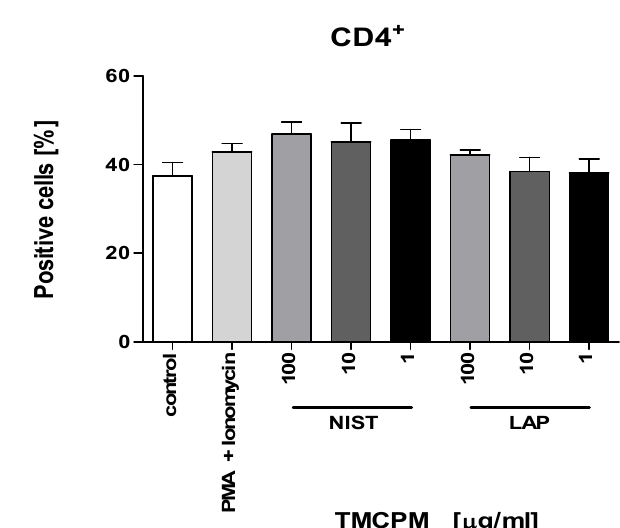
Figure 1. Effect of TMCPM (NIST or LAP) on the level of expression of CD4 on the surface of T cells and frequency of CD4+ T cells. PBMC were stimulated for 5 h with PMA + ionomycin or with NIST or LAP particles, stained with anti-CD4-PerCP-Cy5.5 conjugated mAb and analyzed by flow cytometry. ( A ) Histogram overlay shows fluorescence intensity (PerCP-Cy5.5) of CD4+ cells. Grey histogram—fluorescence intensity of CD4+ cells in a control culture (without stimulation), black histogram—fluorescence intensity of CD4+ cells in the samples stimulated either with PMA (50 ng/mL) + ionomycin (100 ng/mL) (left), 100 μg/mL LAP (middle) or 100 μg/mL NIST (right). Note a decreased expression of CD4 after stimulations of PBMC cells (decreased mean fluorescence intensity). Representative data from one out of thirteen experiments performed are shown. ( B ) Mean ± SEM percentage values of CD4 positive lymphocytes in control cultures (without stimulation) and in the groups stimulated either with PMA (50 ng/mL) + ionomycin (100 ng/mL) or LAP or NIST used at three different concentrations (1 μg/mL, 10 μg/mL, 100 μg/mL), calculated from data obtained from thirteen independent experiments (one-way ANOVA test).